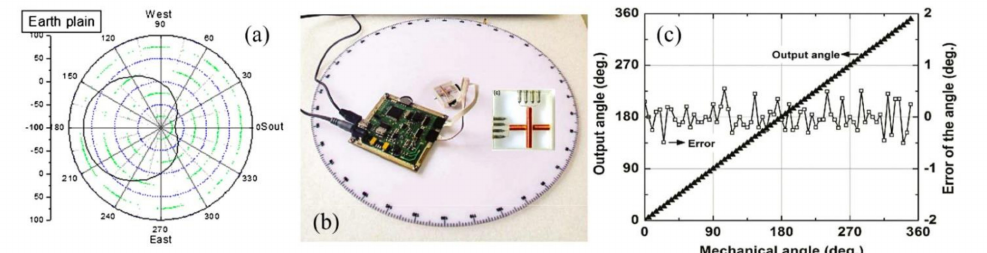
Figure 10. ( a )Output voltage from the magnetoelectric sensor when it is rotated in the Earth’s plane [73]. ( b ) Photograph of the experimental rotation system and ( c ) the accuracy measurement of spatial angles